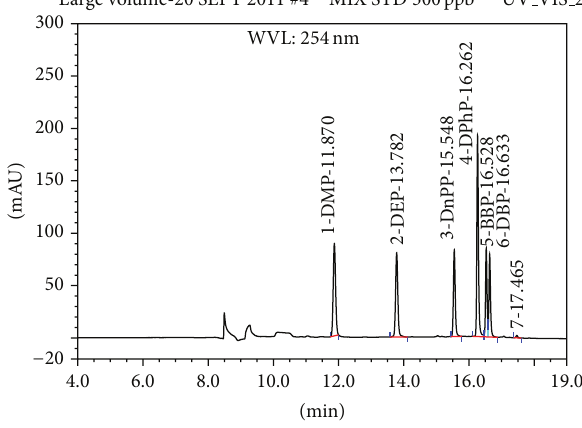
Figure 3: The chromatogram of six phthalate plasticizers.